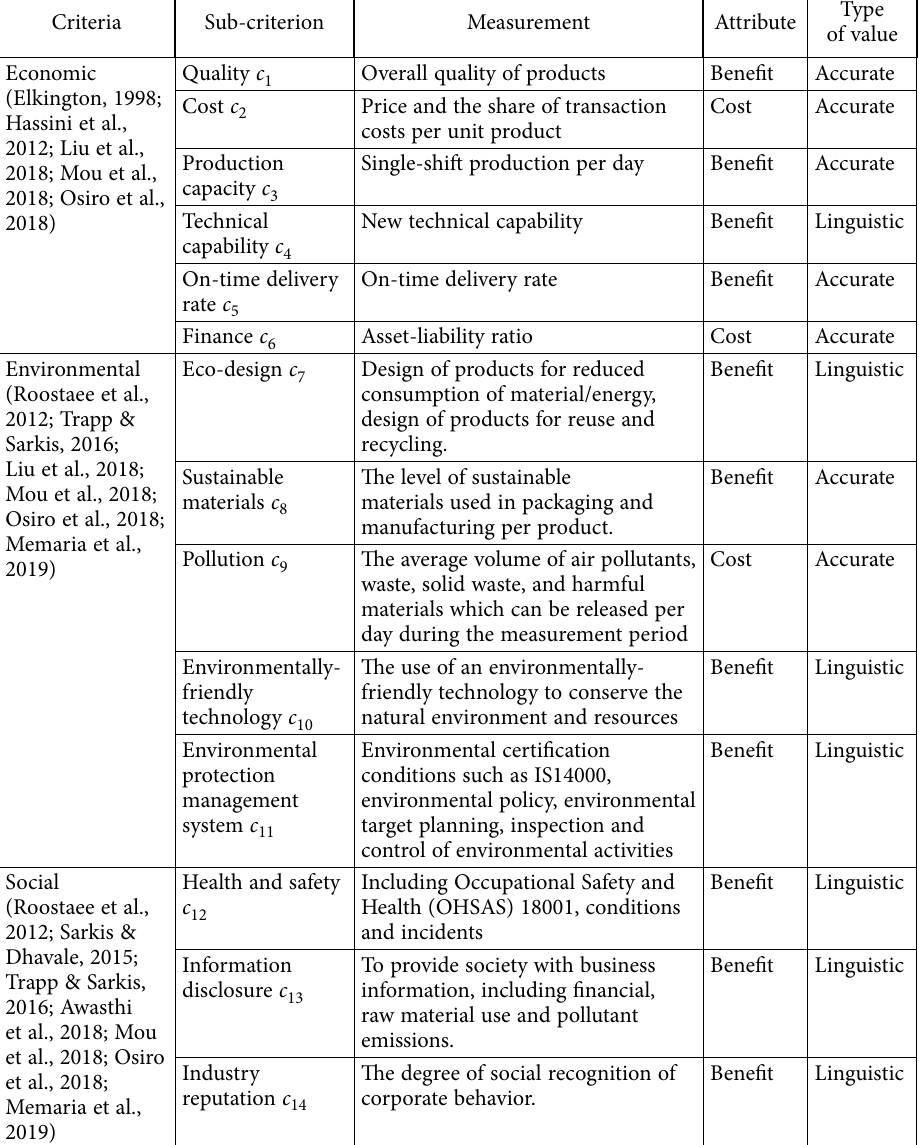
Table 1. The evaluation criteria